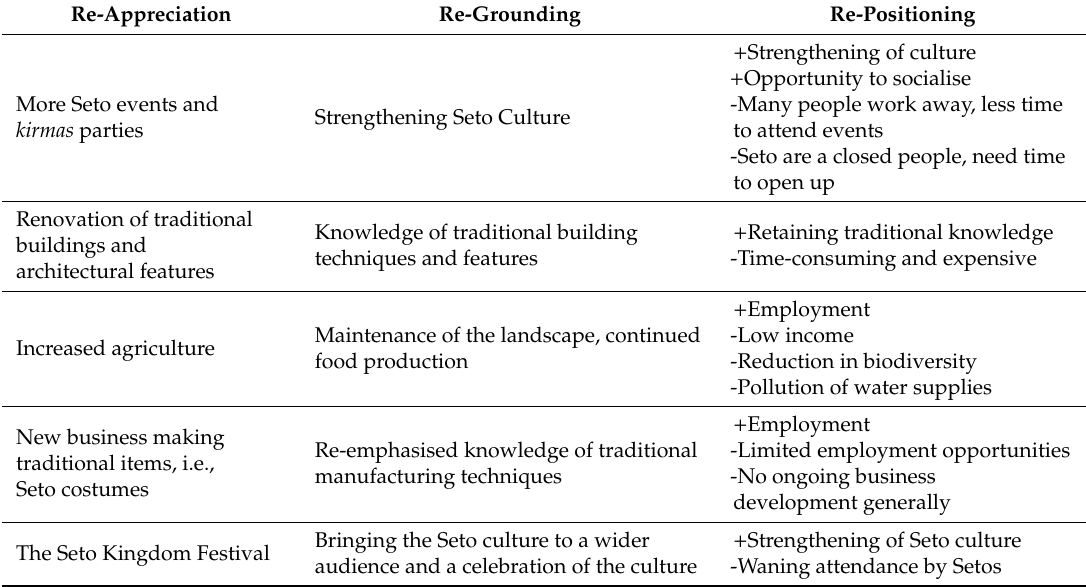
Table 3. The most important aspects of place-shaping in